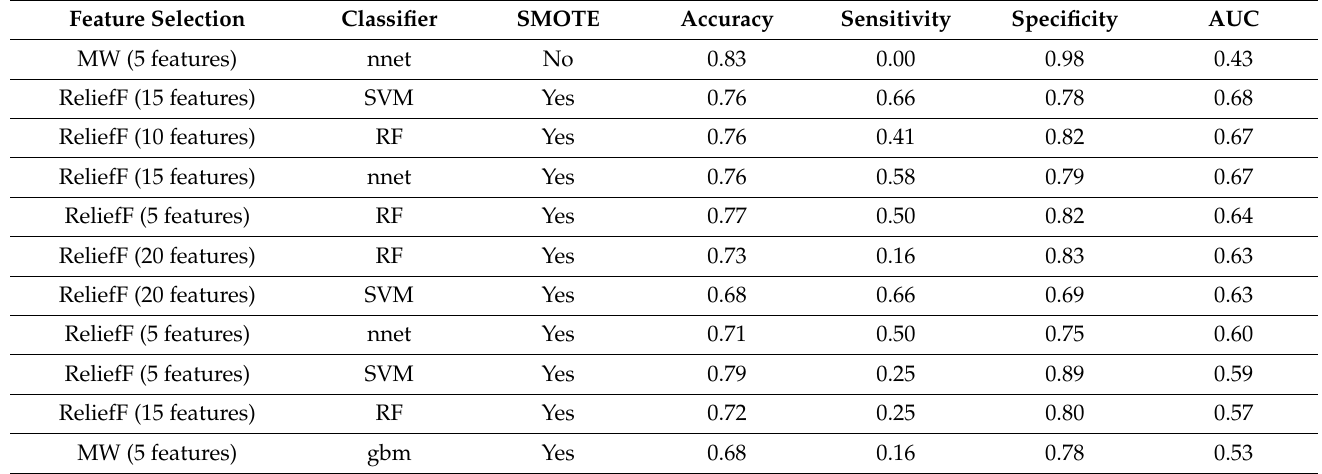
Table 3. EGFR mutation prediction results on Test dataset, base